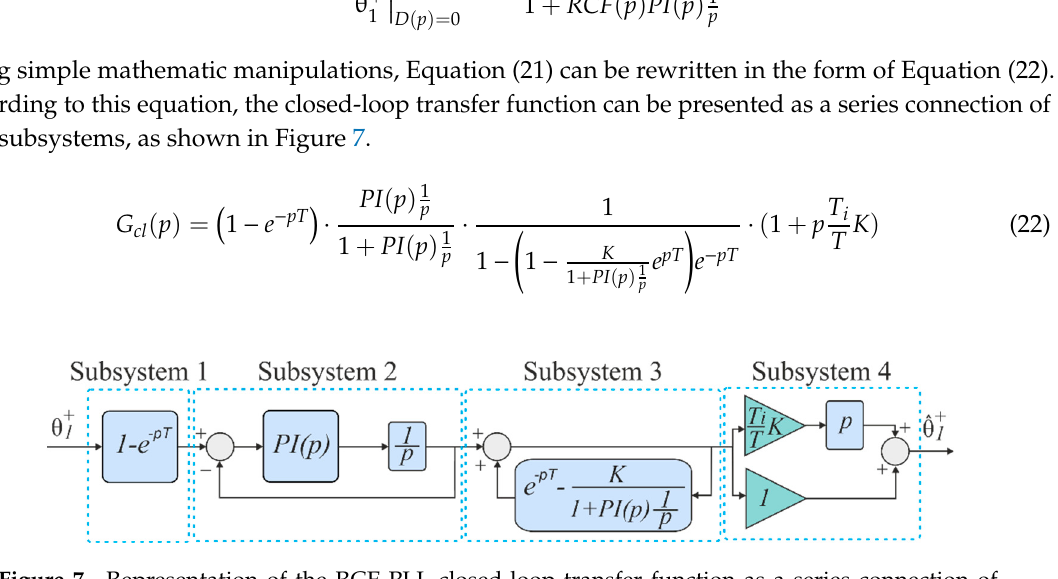
Figure 7. Representation of the RCE-PLL closed-loop transfer function as a series connection of four subsystems.